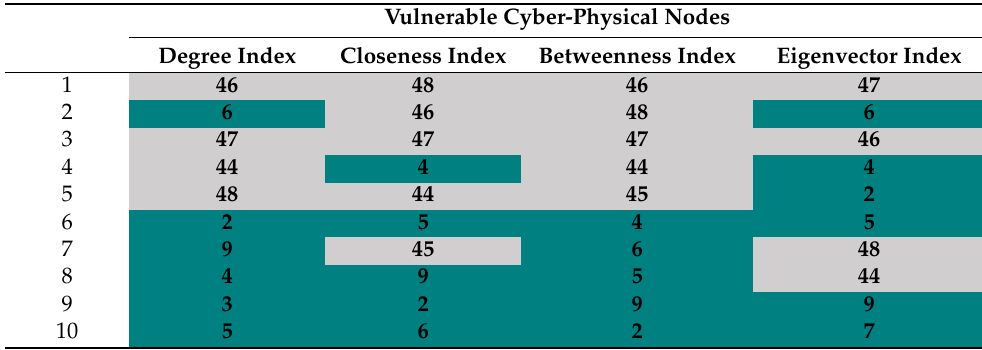
Figure 6. Node degree vulnerability values of the cyber-physical IEEE 14-bus test case. Table 3 ranks the 10 most vulnerable nodes in the CPS according to each of the centrality indexes. Nodes corresponding to the OT layer are highlighted in grey, and those representing the IT layer are coloured in green. First, it is observed that the most vulnerable elements in the CPS correspond to routers located at nodes 46 and 47 (cyber layer) and nodes 4 and 6 (physical layer). Table 3. Ranked list of vulnerable cyber-physical nodes.